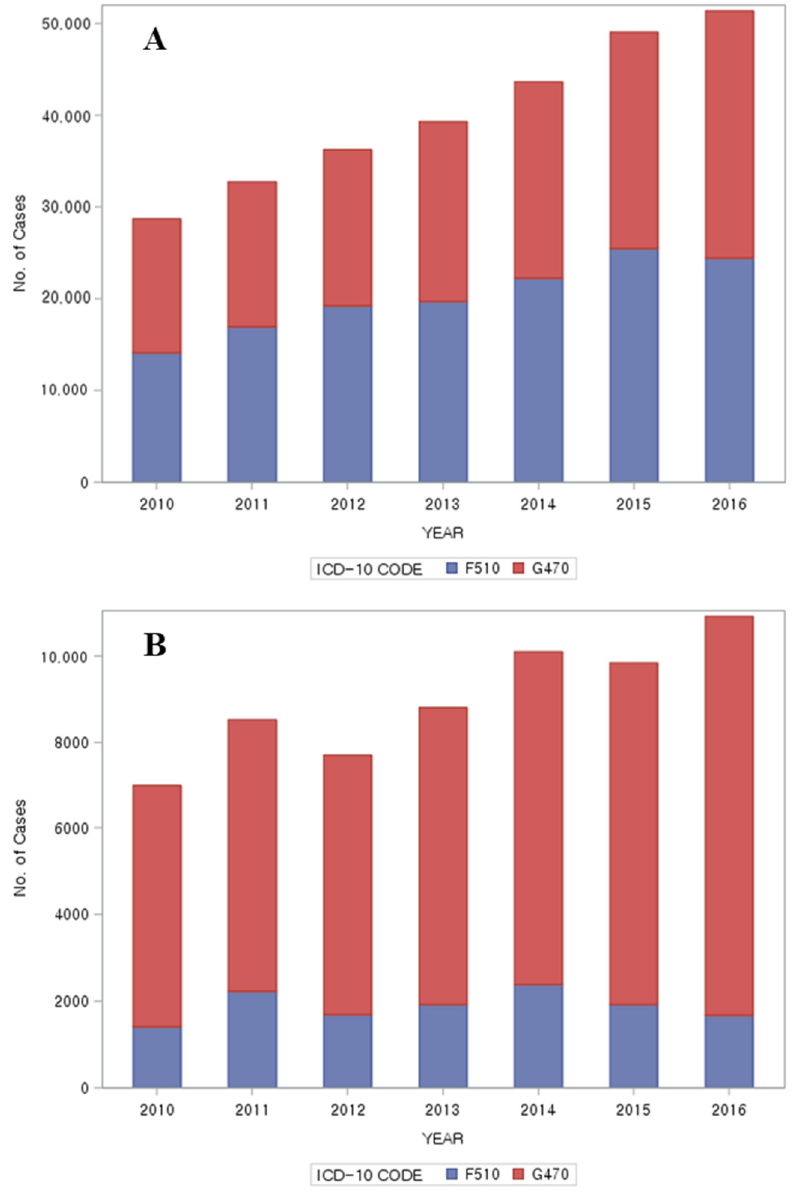
Figure 3. Number of cases per ICD-10 code F510, G470; ( A ): Western medicine; ( B ): Korean medicine. ICD-10 = International Classification of Diseases, Tenth Revision.